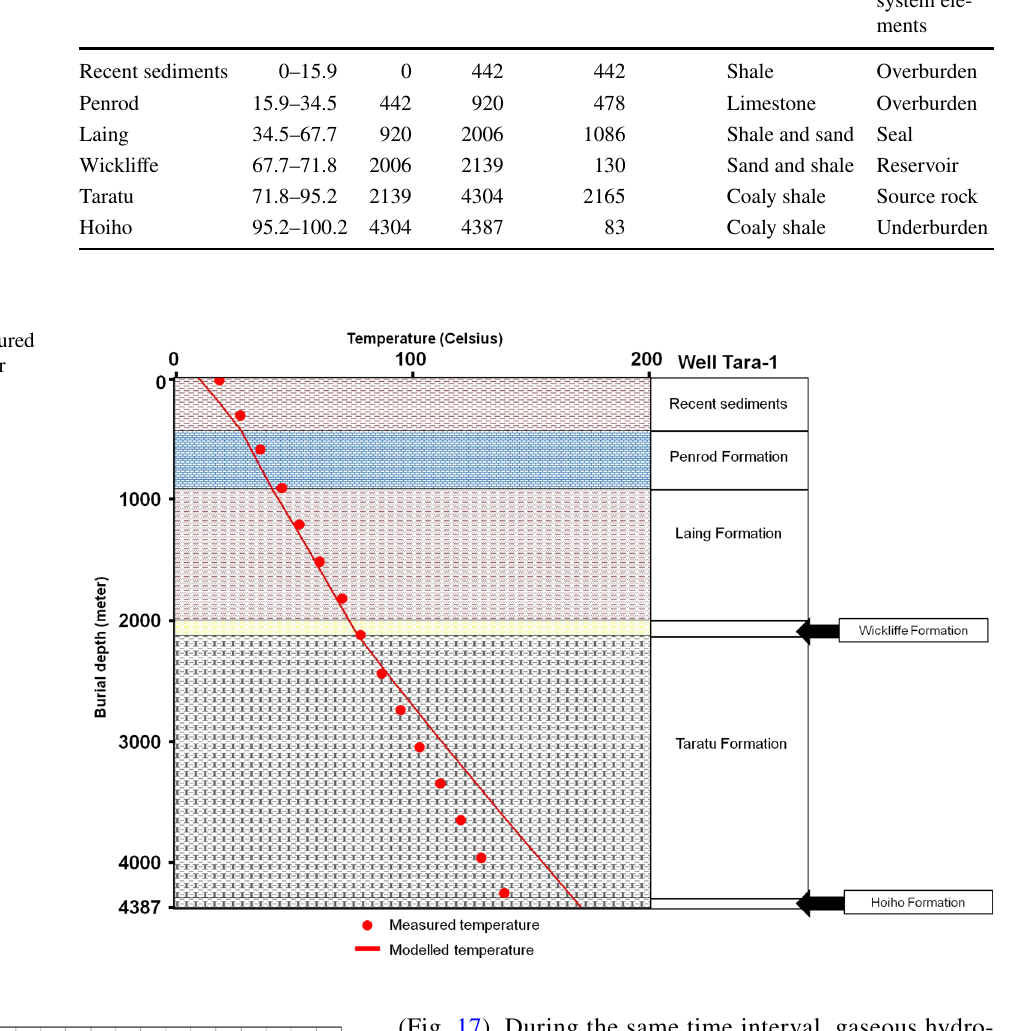
Table 3 Input parameters for 1-D modeling of Well Tara-1